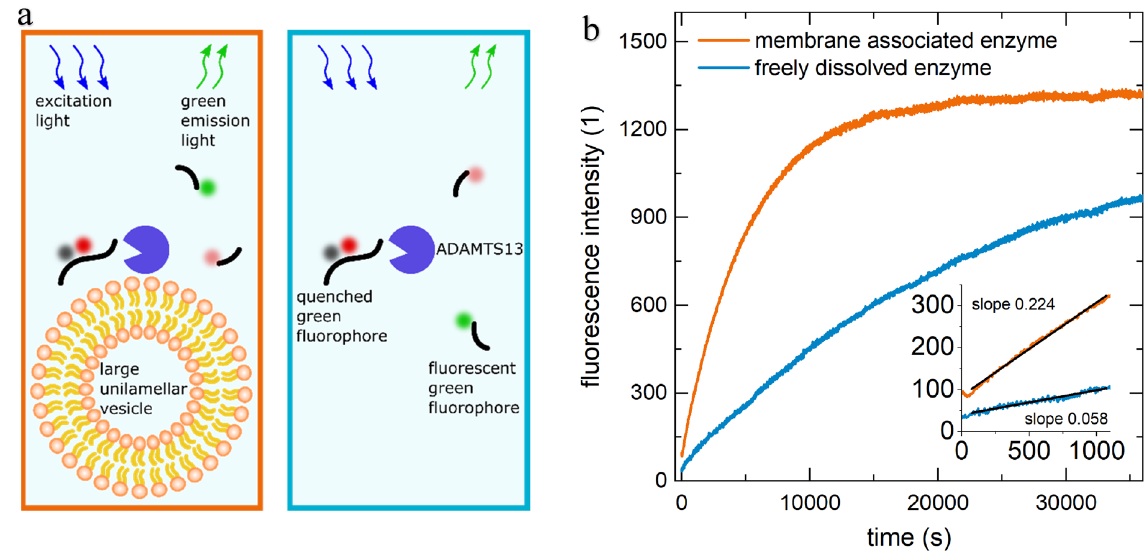
Figure 4. ( a ) Illustration of the experimental design. One well (left, orange frame) contains the substrate, enzyme, and vesicles, whereas in the other (right, blue frame), the vesicles are substituted by buffer. The assay is based on fluorescence-resonance-energy-transfer (FRET). Embedded ALEXA fluorochromes in the A2 domain of VWF (Von-Willebrand-Factor) are decoupled after cleaving of the substrate, this leads to an increase of the green fluorescence. ( b ) Typical kinetic measurement (T = 24 °C) of freely dissolved enzyme (blue) and membrane (14:0 PC) associated enzyme